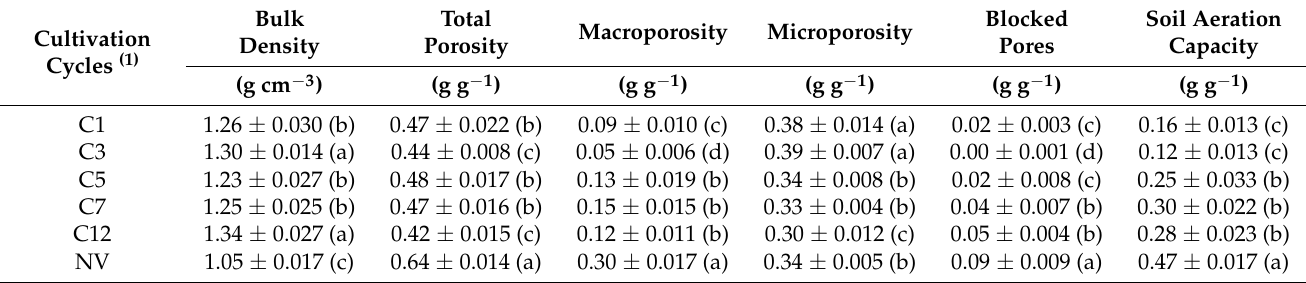
Table 3. Average values and mean standard error ( ± ) of the physical attributes of Ferralsol in environments of sugarcane production and native vegetation (NV), in the midwest region of